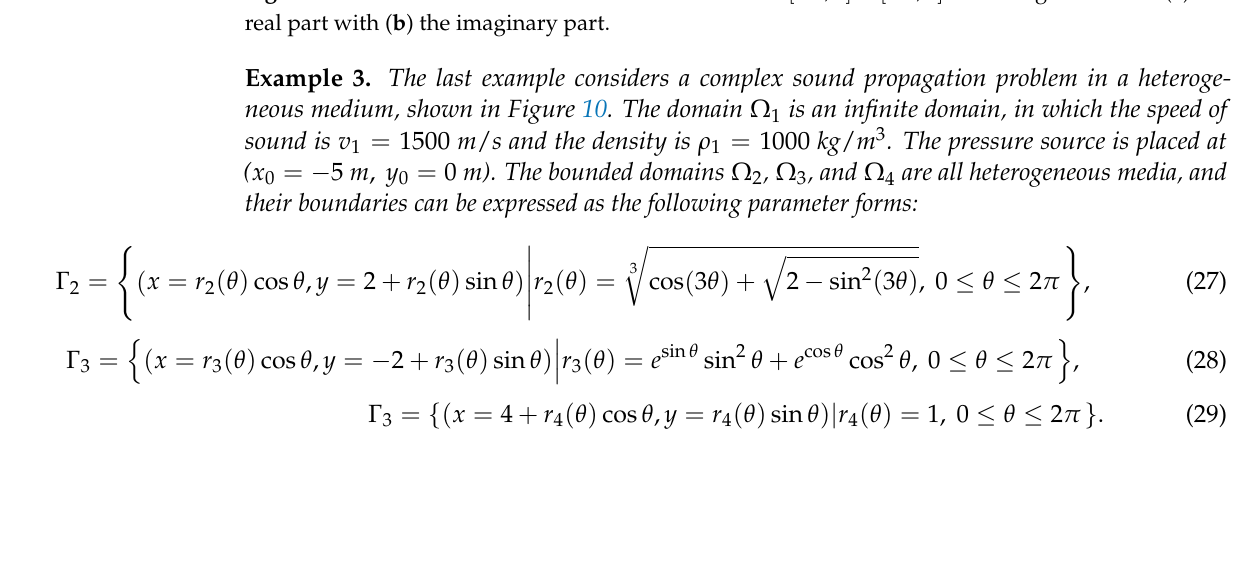
Figure 9. Distributions of absolute error in the domain [ − 2,2 ] × [ − 2,2 ] with irregular nodes: ( a ) the real part with ( b ) the imaginary part.